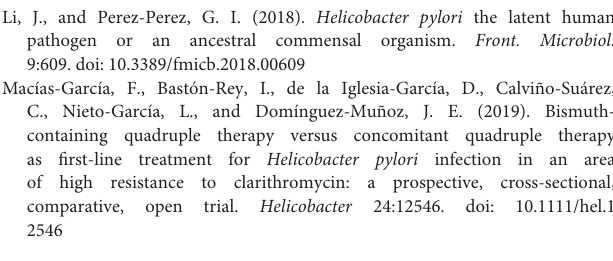
comparative, open trial. Helicobacter 24:12546. doi: 10.1111/hel.1 2546